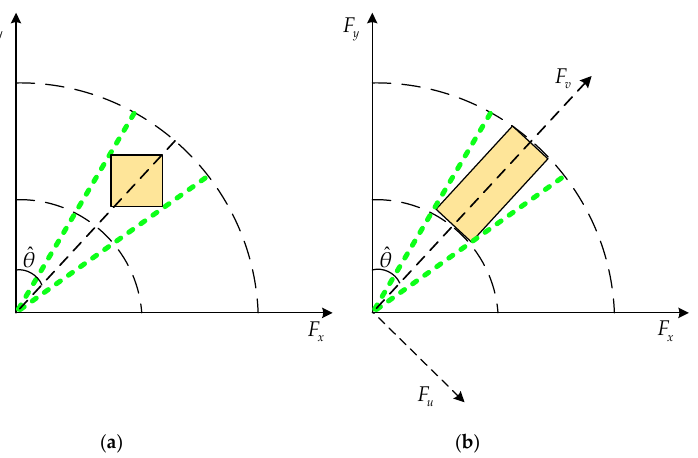
Figure 4. ( a ) Spectrum support region selection before the spectrum rotation; ( b ) Spectrum support region selection after the spectrum rotation.